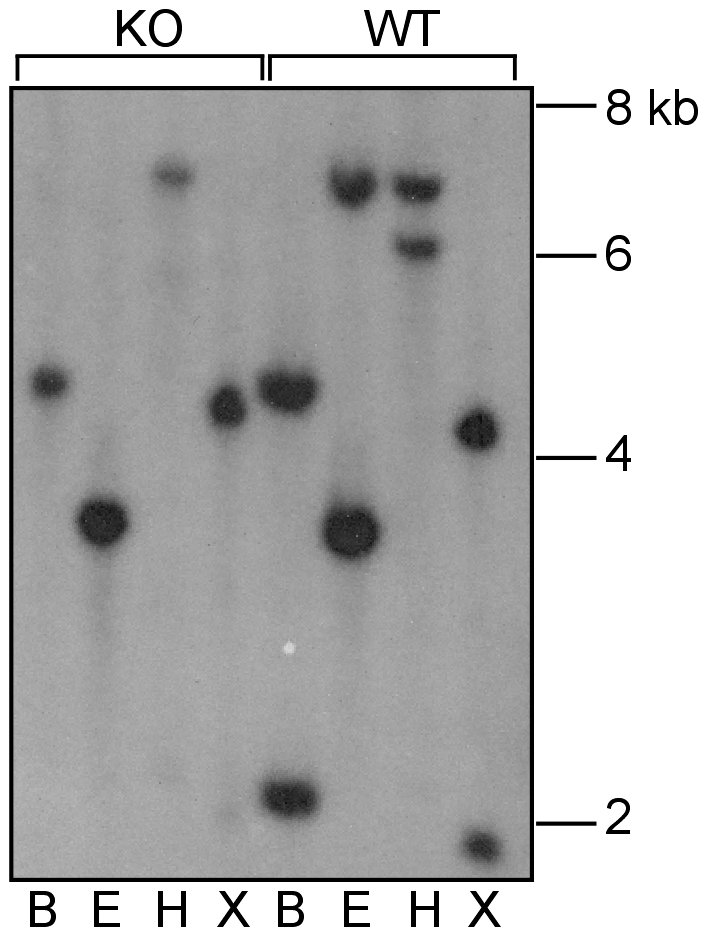
Detection of an Xiap pseudogene by Southern analysis.Genomic DNA was digested to completion with BamHI (B), EcoRI (E), HindIII (H), or XbaI (X), and probed with a 510 bp fragment from exon 2 of Xiap. Bands of the expected size for the Xiap gene were revealed in the WT DNA. In addition, both WT and Xiap K/O DNA showed bands of the sizes predicted from the sequence of the Xiap-like gene on chromosome 7.